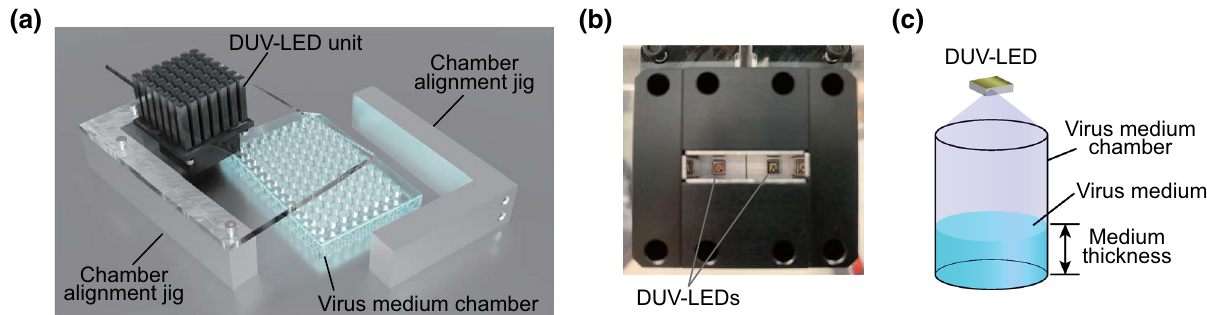
Figure 2. Schematics of the DUV-LED irradiation apparatus. ( a ) Three-dimensional view of the DUV-LED irradiation apparatus. The virus medium chamber is set just under the DUV-LED unit and is supported by the chamber alignment jigs. ( b ) Bottom view of the DUV-LED unit with two DUV-LEDs. ( c ) Schema of the virus medium chamber used for DUV-LED irradiation. The DUV-LED irradiation area is large enough to obtain uniform